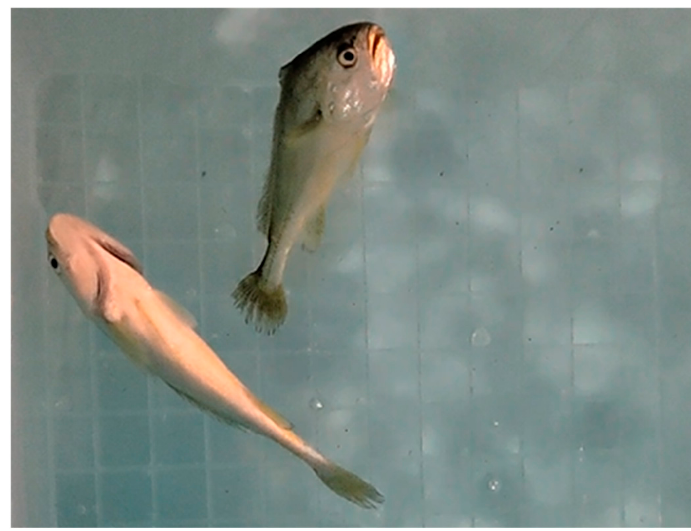
Figure 8. Loss of balance in L. polyactis after noise exposure for 0.5 h.